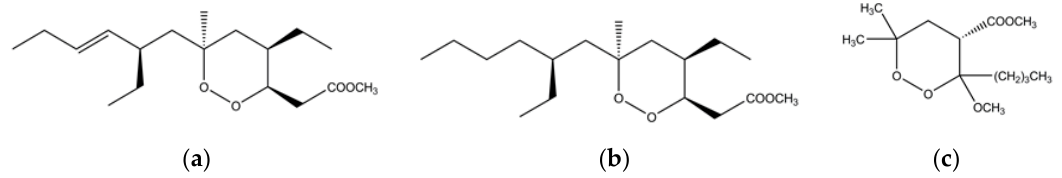
Figure 5. Chemical structure of ( a ) plaktorin; ( b ) dihydroplaktorin and ( c ) 3-methoxy-1,2-dioxane synthetic analogue.